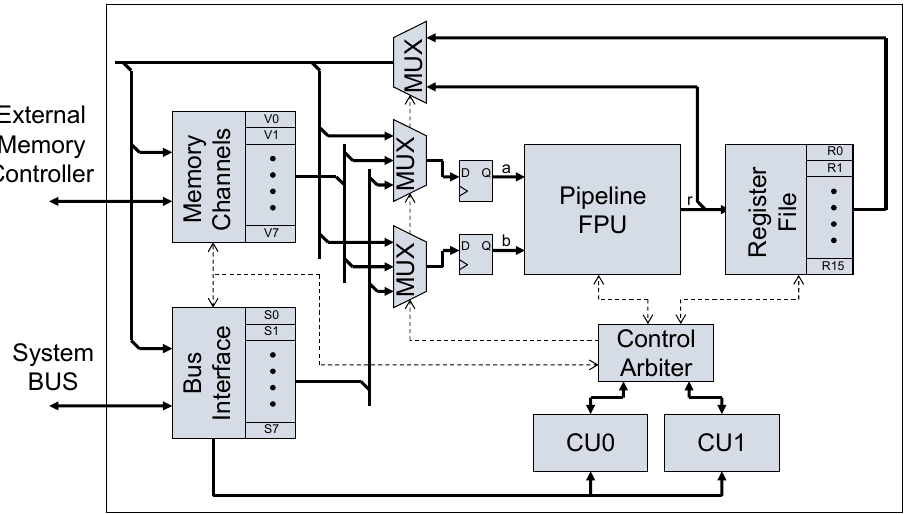
Figure 5. Overview of the FPBA architecture.